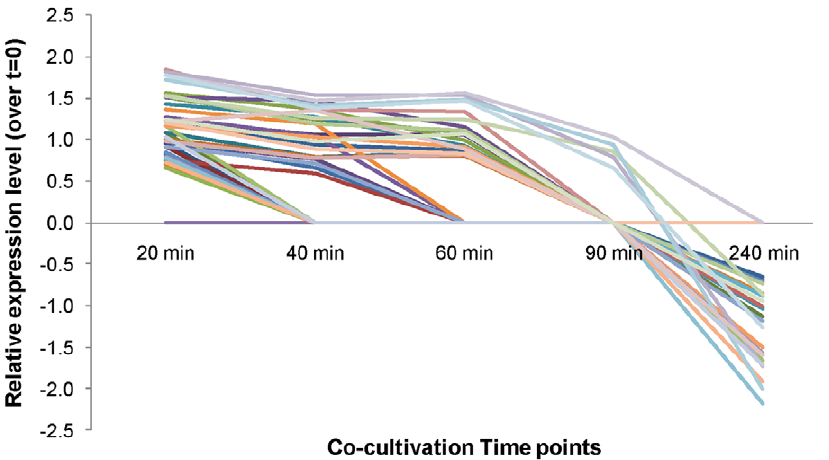
Figure 3. Schematic representation of the number of differentially regulated meningococcal genes. Genes were identified in blood co- cultivation experiments at different time points, which are indicated by colour keys. Genes were classified into TIGR functional categories. Minus signs indicate down-regulated gene number.